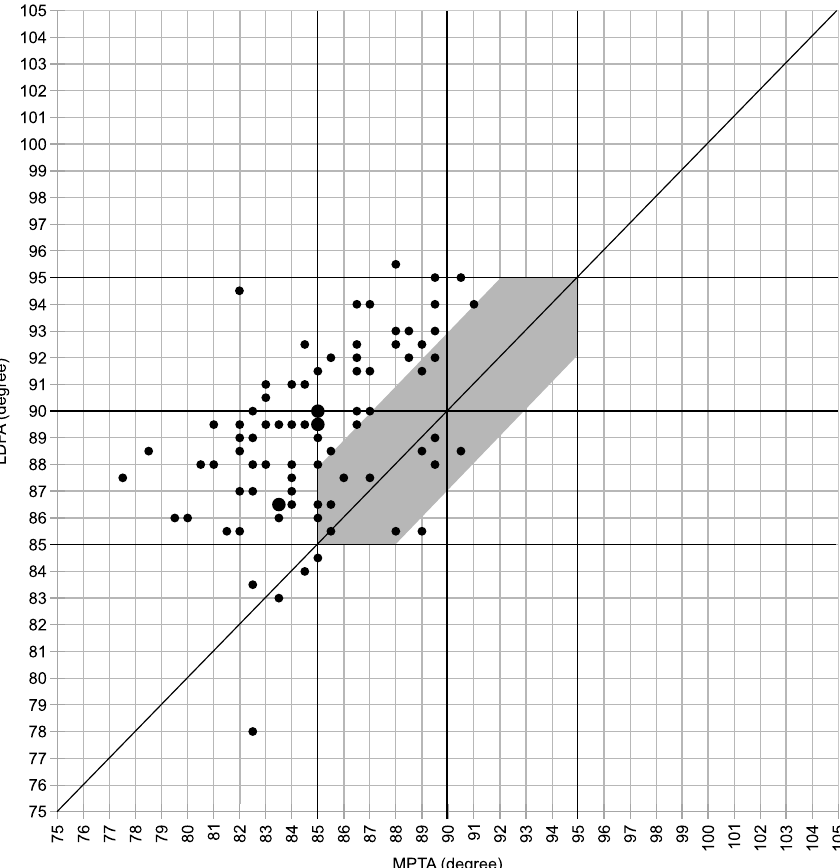
Fig. 4 Scatterplots of preoperative LDFA and MPTA. The shaded areas represent patients in the rKA target zone during preoperative planning. Twenty percent of all cases are in this safety zone and the others required modifications of the cutting plans. Abbreviations: LDFA: lateral distal femoral angle; MPTA: medial proximal tibial